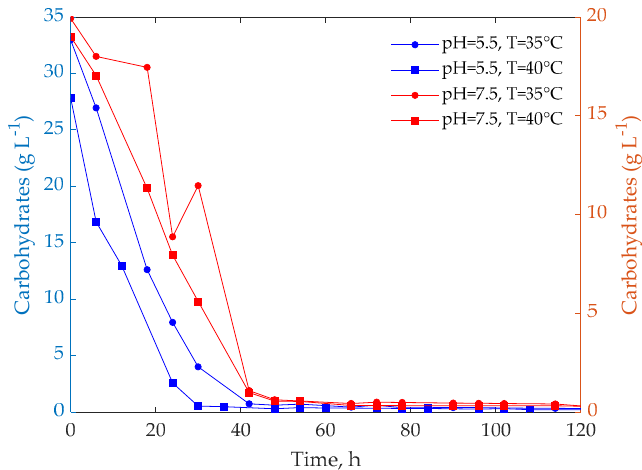
Figure 2. The dynamic profile of total carbohydrate consumption. However, the COD consumption only reaches a consumption between 30 and 50%, which suggests that the consumption of lipids and proteins was less significant. At pH = 7.5 and T = 40 °C, 50% of the COD consumption is reached, while at pH = 5.5 and T = 35 °C the minimum consumption is obtained with 30% (Figure 3). These results correspond to those obtained by Perna et al. [49], who achieved COD removal percentages between 14% and 32% using diluted whey.